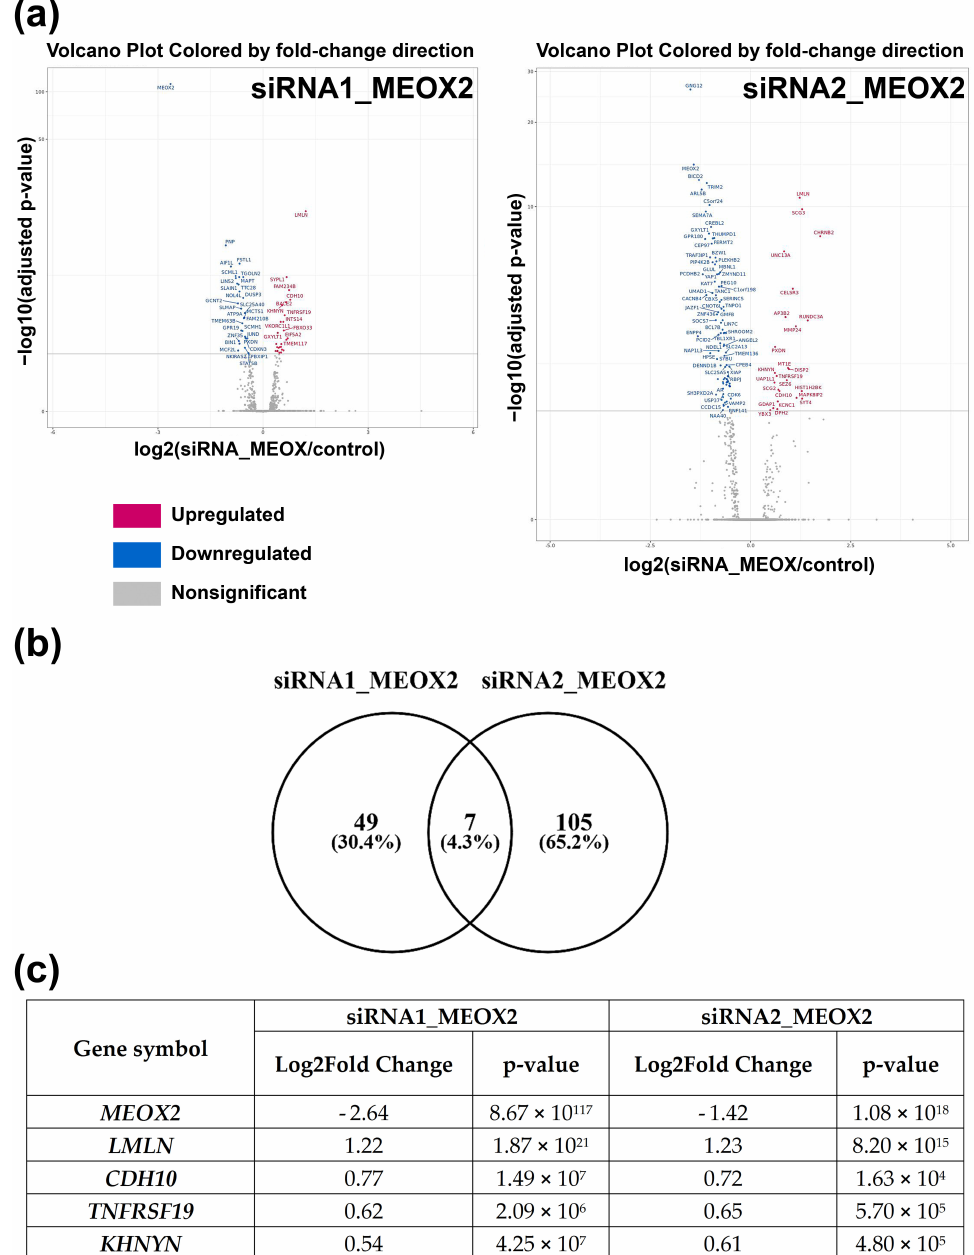
Figure 6. RNAseq analysis of MEOX2-regulated genes in GSC-2, -6, and -10. ( a ) Volcano plots of significant differentially expressed genes after MEOX2 inhibition by two different siRNA; ( b ) Venn diagram of common differentially expressed genes between two siRNA; ( c ) List of four common genes affected in same way by MEOX2